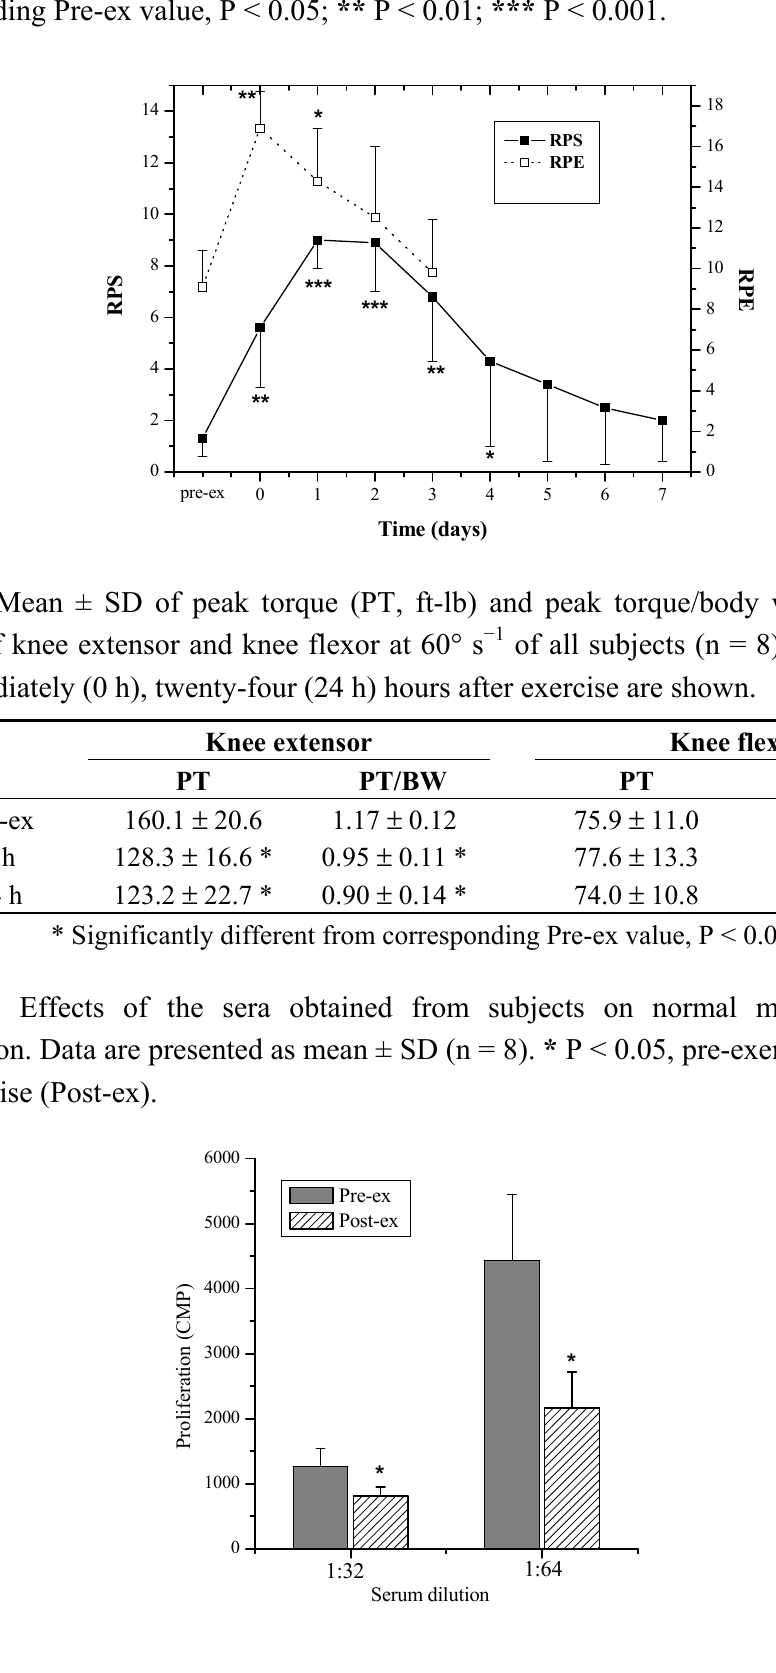
Figure 1. Mean ± SD of ratings of perceived exertion (RPE) and perceived soreness (RPS) of all subjects (n = 8) before (Pre) and immediately (0), one (1), two (2), three (3), four (4), five (5), six (6) and seven (7) days after exercise. * Significantly different from